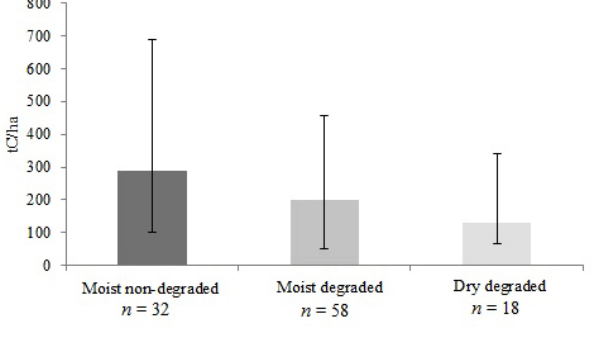
Fig. 2 . Average forest carbon stocks in the Bale Mountains by forest type with 95% bootstrapped confidence